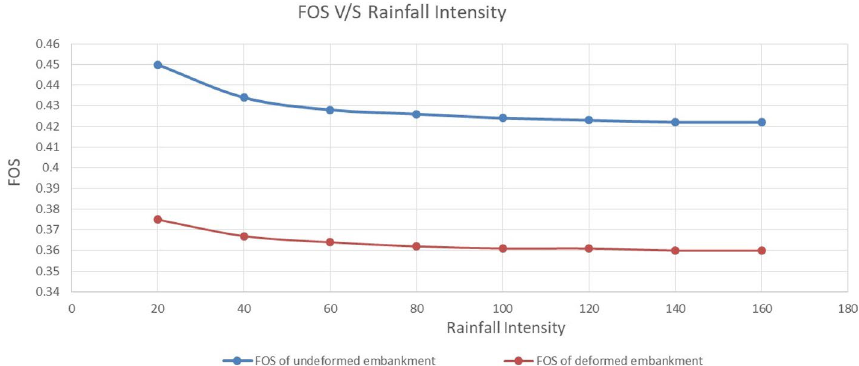
Fig. 23 FOS variation over the deformed and undeformed by varying the rainfall